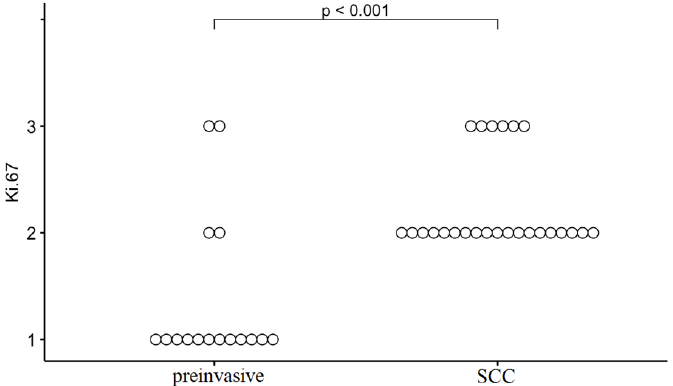
Figure 6. Comparative statistical analysis of Ki67 between preinvasive squamous cell lesions and SCC. Each circle represents a patient.